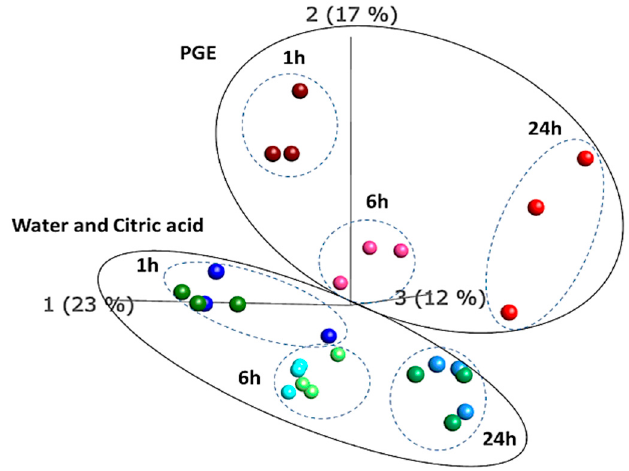
Figure 2. Principal Component Analysis (PCA) of all transcripts from oranges treated with PGE, citric acid or water (control) and analyzed 1, 6 and 24 h post treatment (hpt).